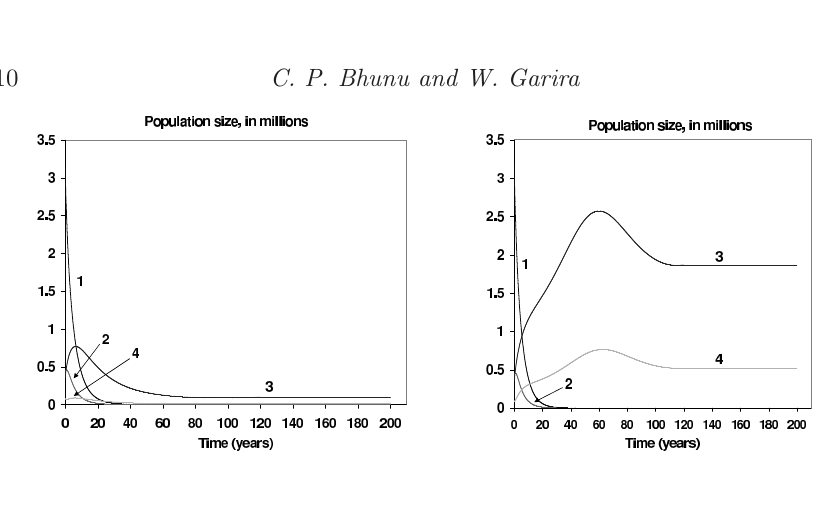
Figure 4. Simulated the effect of quarantine for MDRTB on the latently infected ( E T E T ) and the infectious ( I T and I T ). Series 1, 2, 3 and 4 represent individuals latently 2 1 2 infected with the drug sensitive strain, infectious individuals with drug sensitive strain, in- dividuals latently infected with MDR strain and infectious individuals with MDR strains. Figures (a) and (b) represent quarantine for MDRTB, treatment and chemoprophylaxis